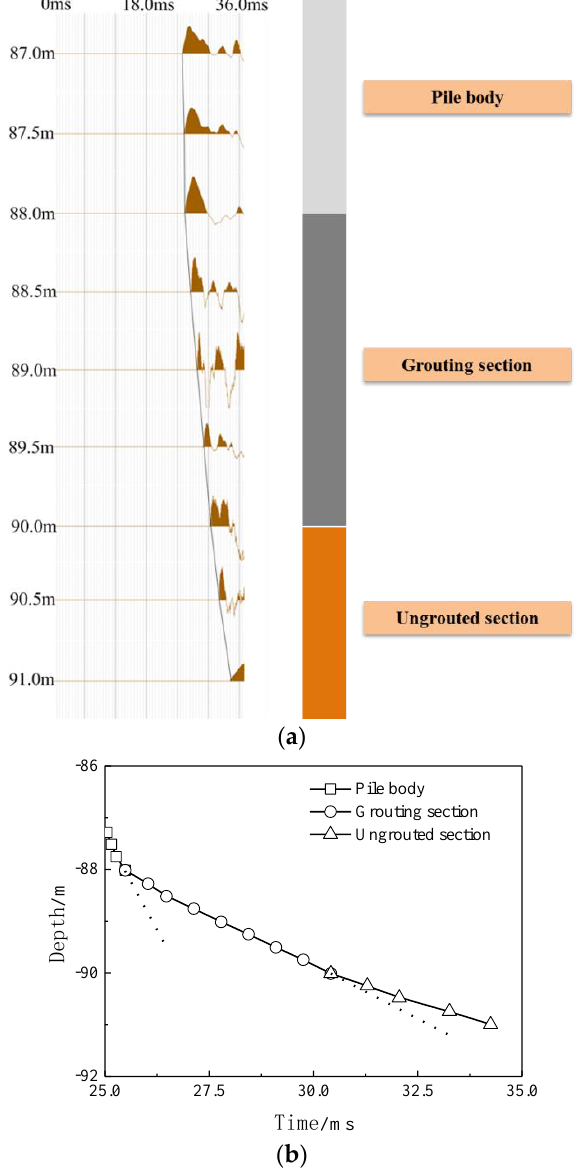
Figure 8. Test result of transmission wave in the No. 1 pile: ( a ) original data; ( b ) processed Data. Figure 9a is the original data diagram of the results of the transmission wave test in the No. 2 pile. After data extraction and redrawing, the processing diagram can be obtained, as shown in Figure 9b, which is consistent with Figure 4. Figure 9 shows that the pile bottom elevation of No. 2 pile is − 88 m, which is basically consistent with the design elevation, − 89 m, so the depth of the pile bottom reinforcement is 1 m. In addition, the wave speed of the pile body is about 3453 m/s, the wave speed of the reinforcement body is about 405